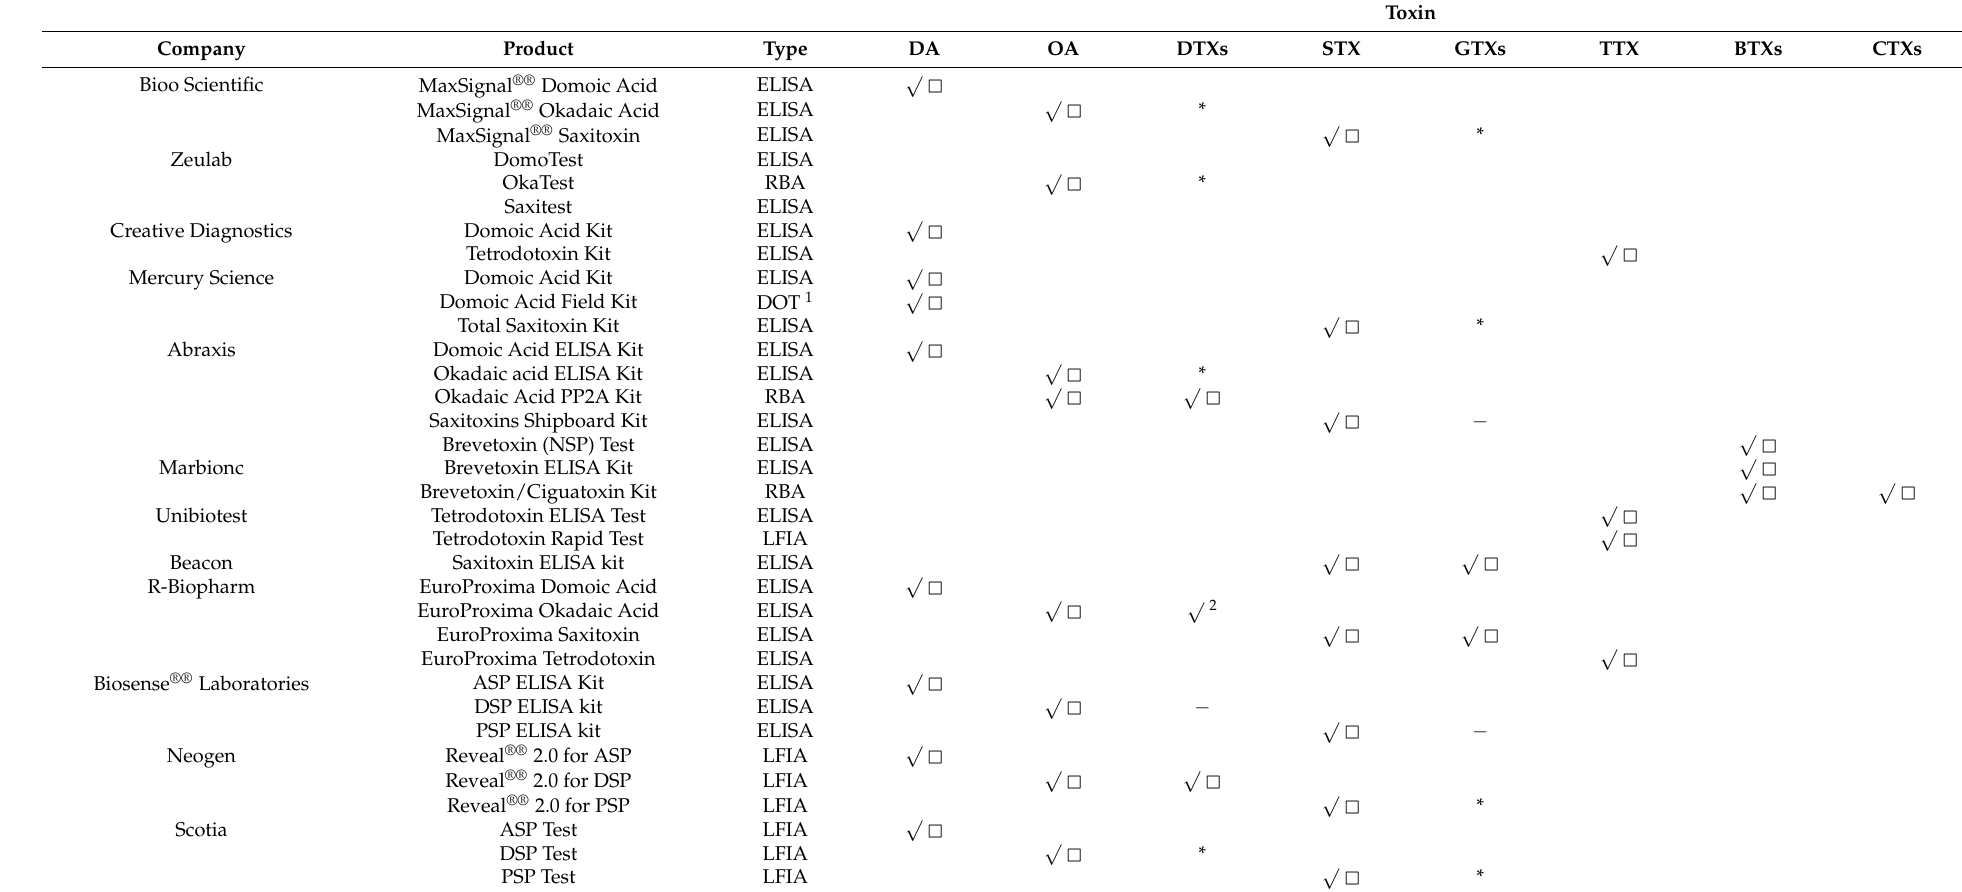
Table 3. A list of commercially available marine toxin detection